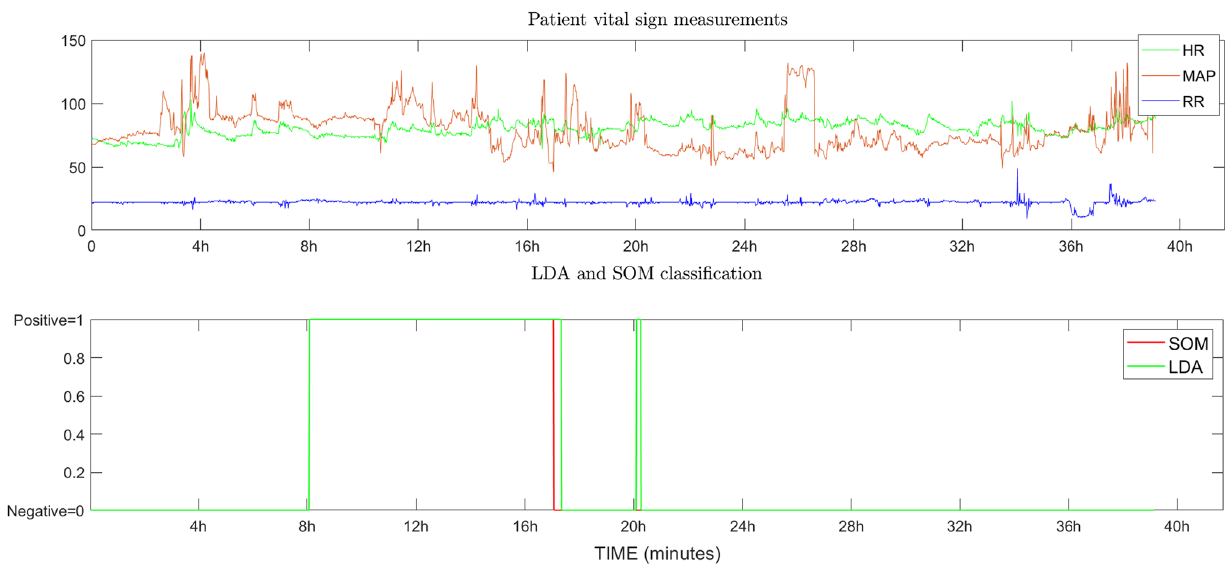
Fig. 8 Vital sign measurements and statistic transformation